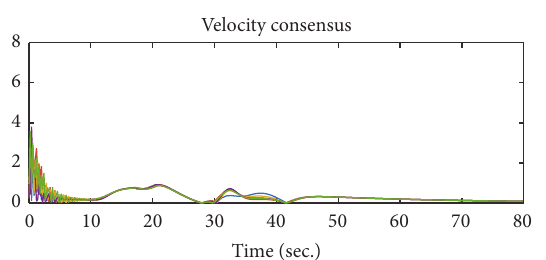
Figure 9: Multiagent velocity convergence in multiple size multiple obstacles.